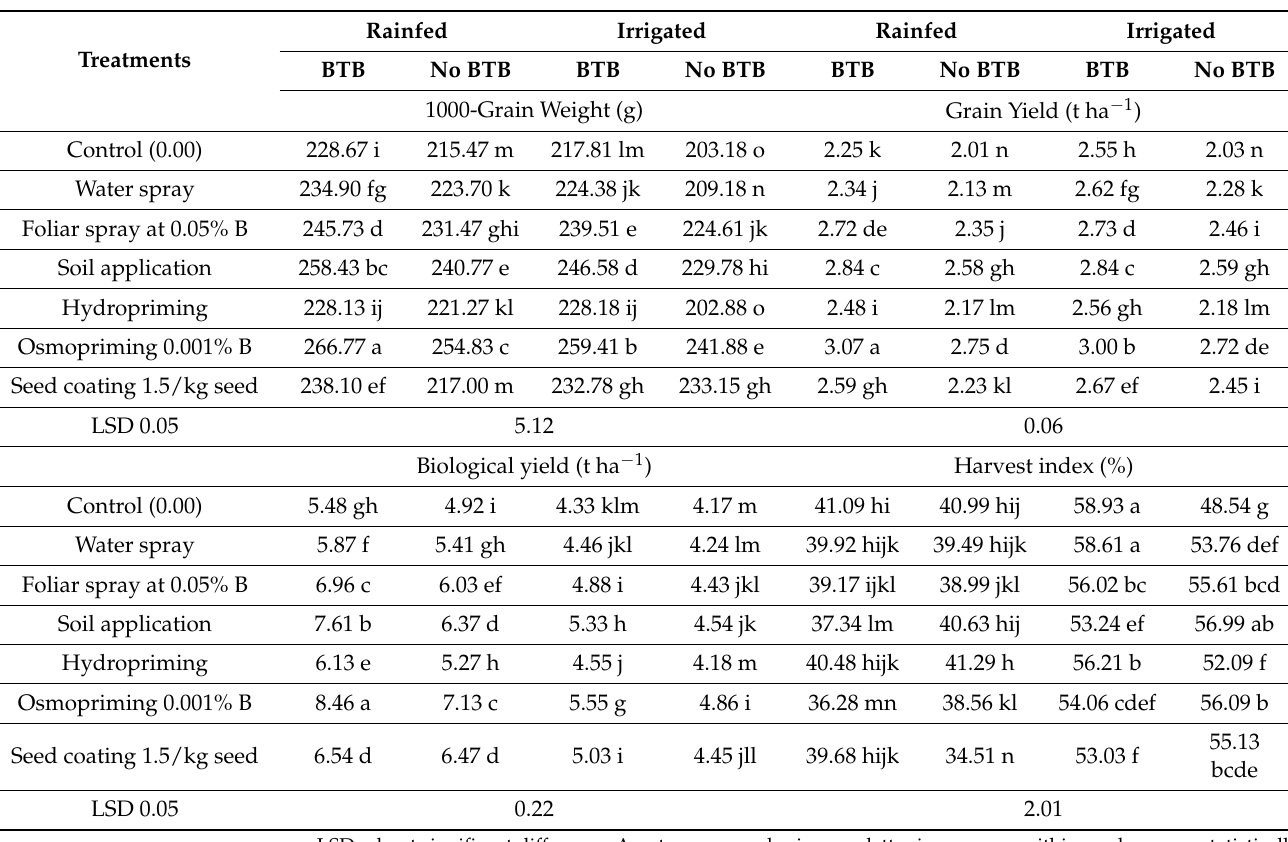
Table 8. The impact of location × BTB inoculation × boron application methods’ interaction on yield and related traits of desi